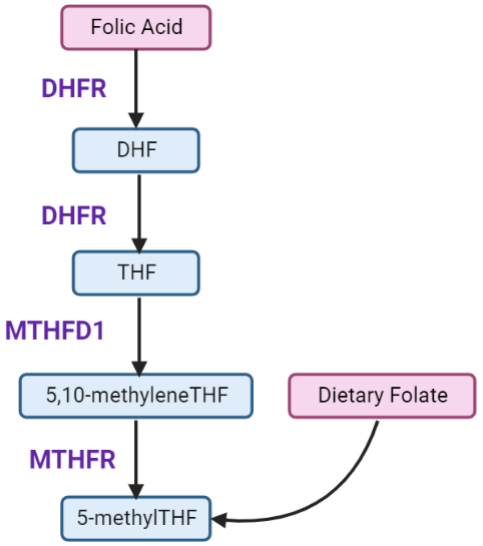
Figure 2. Folic Acid Metabolism. Folic acid (FA) requires reduction by dihydrofolate reductase (DHFR) to dihydrofolate (DHF) and sequentially tetrahydrofolate (THF). THF is then converted to 5,10-methyleneTHF and 5-methylTHF, dependent on methylenetetrahydrofolate dehydrogenase 1 (MTHDF1) and methylenetetrahydrofolate reductase (MTHFR) function. 6.2. Excess FA Reduces MTHFR Protein, Causing a Pseudo-MTHFR Deficiency After conversion of FA to THF, THF is converted by the methylenetetrahydrofolate